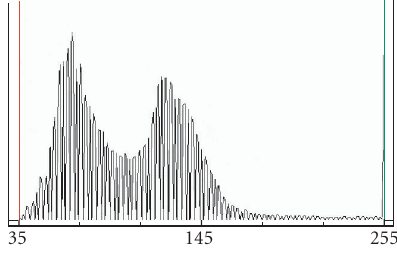
Figure 4.7. Histogram of same area from Figure 4.4 near fire and burnt